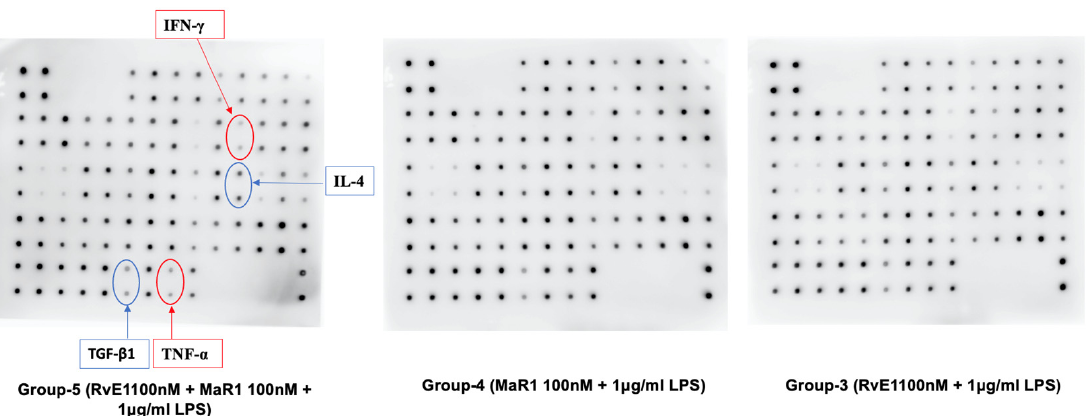
Figure 8 . Human cytokines Antibody array membranes showing the expression of IL-4, TGF- β 1, TNF- α , and IFN- γ among the three SPM treated study groups. Owing to limited supply of membranes for multiple repeats for all samples and groups, the triplicate runs ( n = 3) were performed only for the experimental groups.